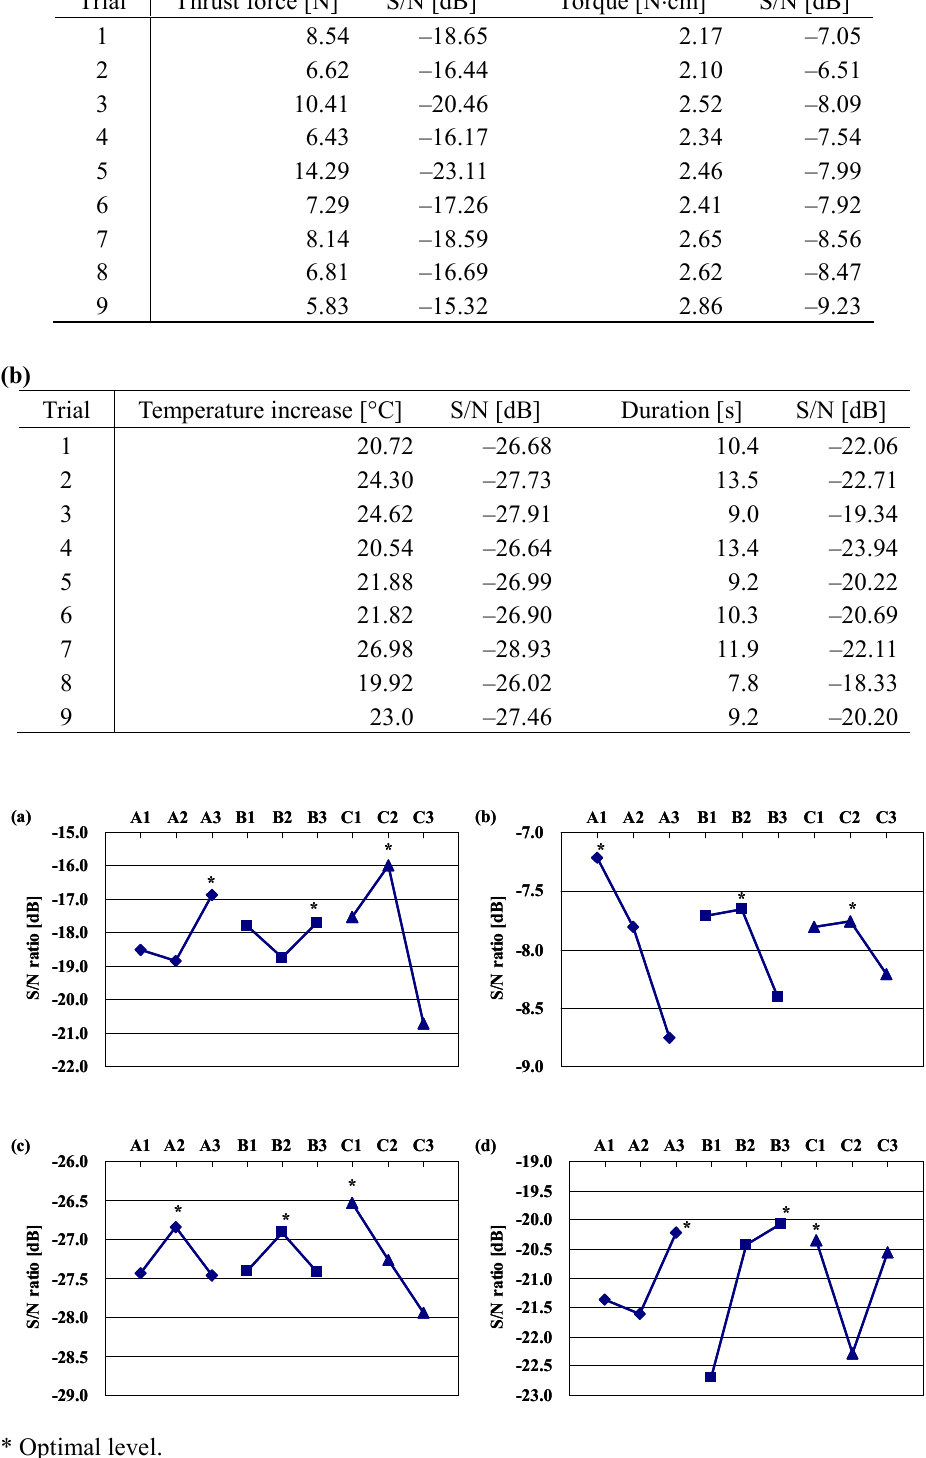
Figure 4 S/N ratio plots for the drilling characteristics at each level for each design factor: (a) thrust force, (b) torque, (c) temperature increase, and (d)